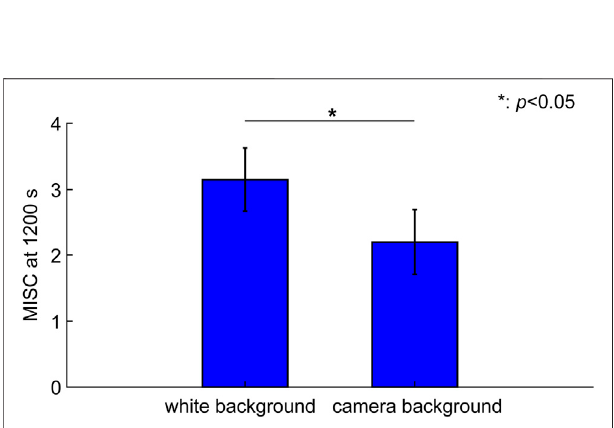
FIGURE 5 | Average Misery Scale (MISC) per minute. Most of the time, the MISC in the camera background condition was lower than in the white background condition. Error bars indicate the standard error.